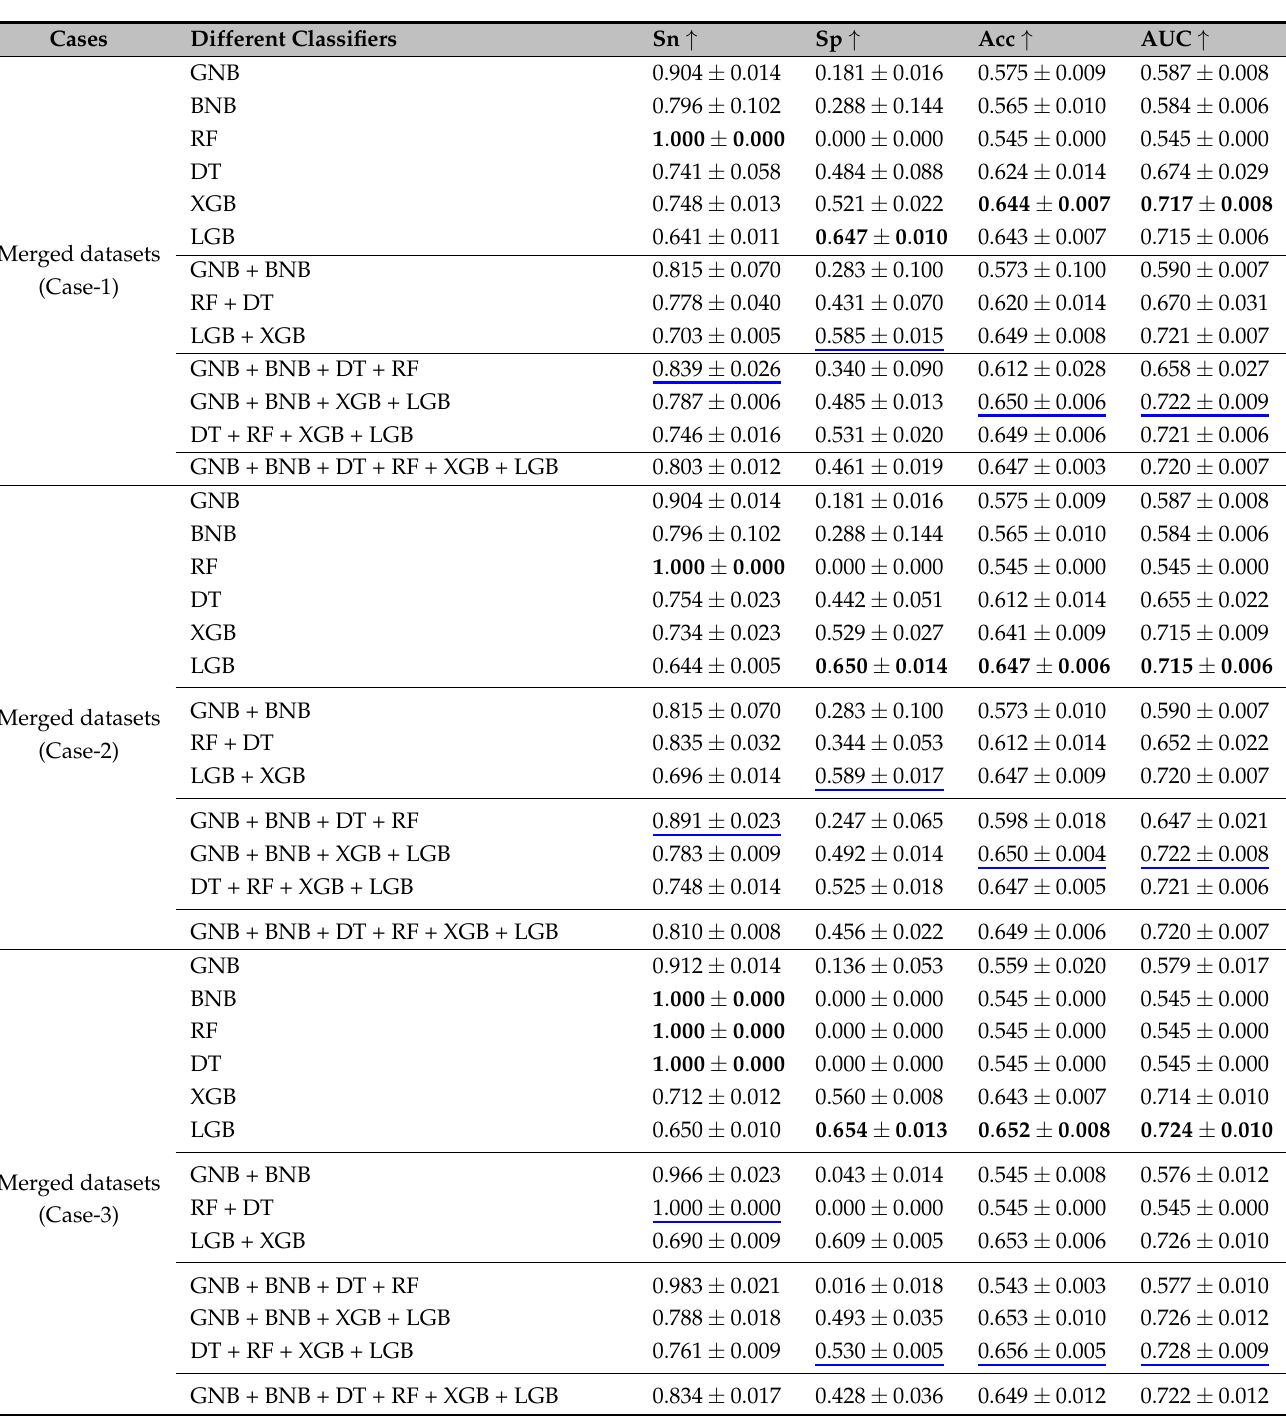
Table 8. Diabetes classification results are shown in case-1, case-2, and case-3, where features are selected from the DDC-2017 dataset, DDC-2011 dataset, and both datasets, including missing value imputation and hyperparameter tuning. The metrics of the best-performing single model are highlighted in bold fonts, whereas the blue underlines are used to indicate them in the proposed ensemble